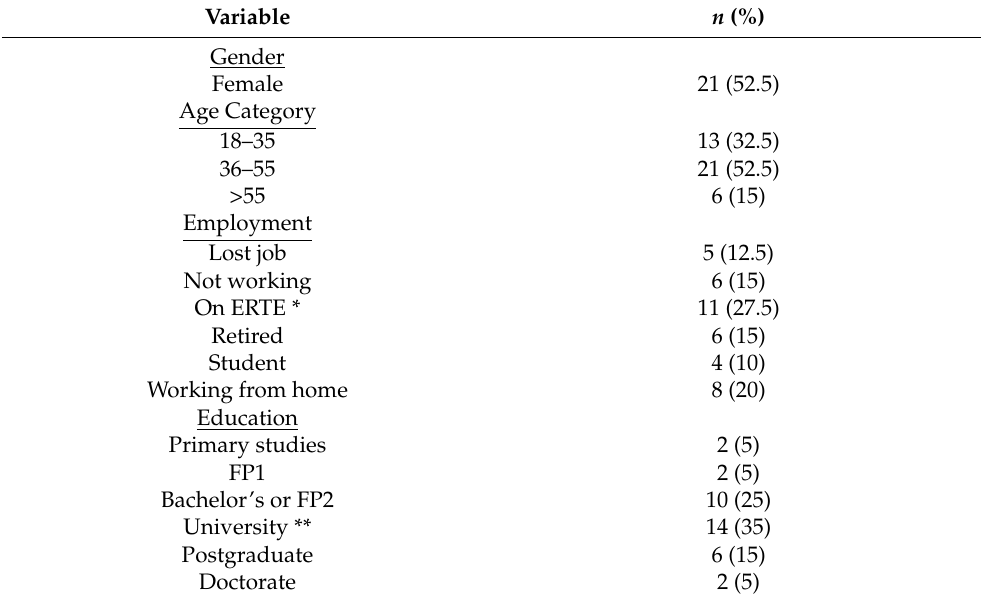
Table 1. Qualitative Participant Demographics ( n =